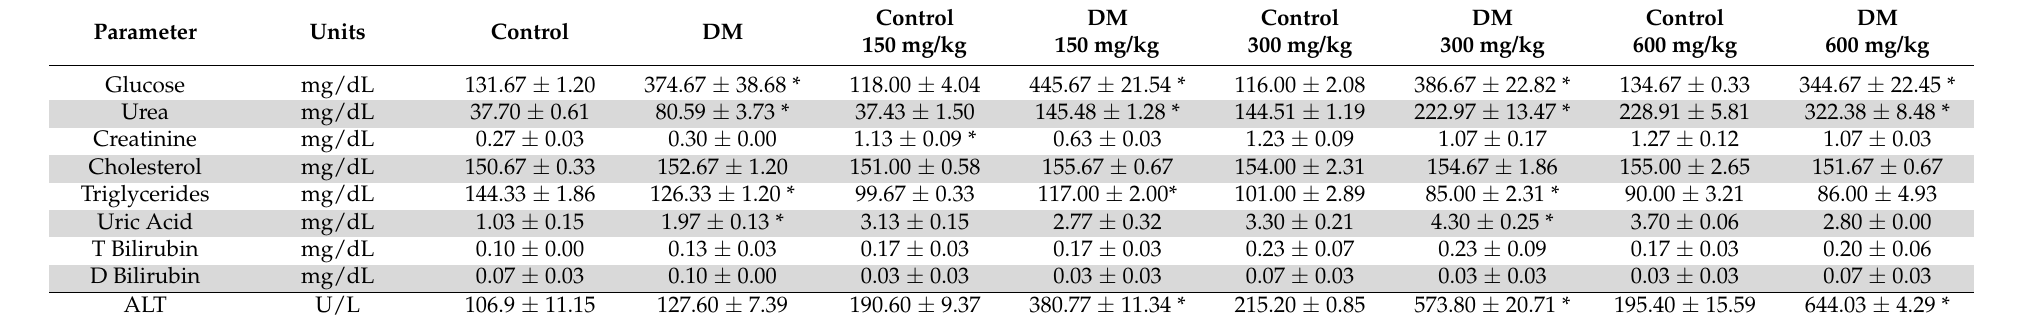
Table 1. Blood chemistry from rats treated with Agave lechuguilla– guishe aqueous